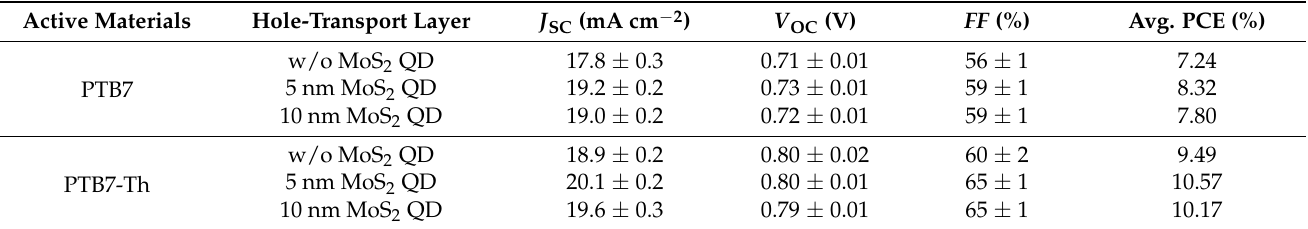
Table 1. Device performance parameters of PTB7 (PTB7-Th):PC 71 BM with varying hole-transport materials based on 5- and 10-nanometer MoS 2